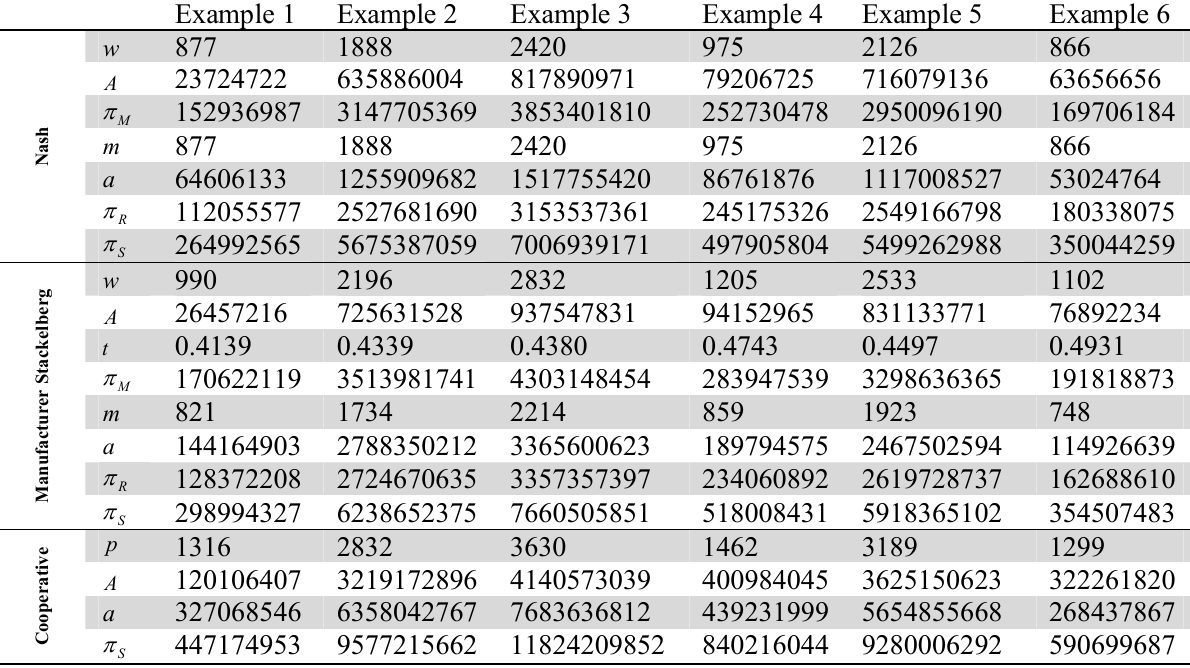
Decisions and profits of players in monopolistic retailer